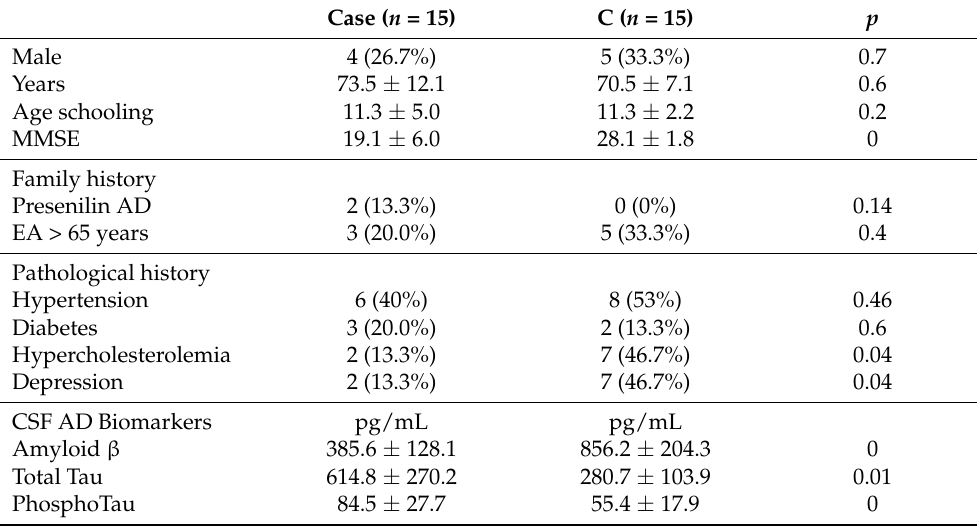
Table 2. Demographic and clinical characteristics of the patients from whom CSF samples were